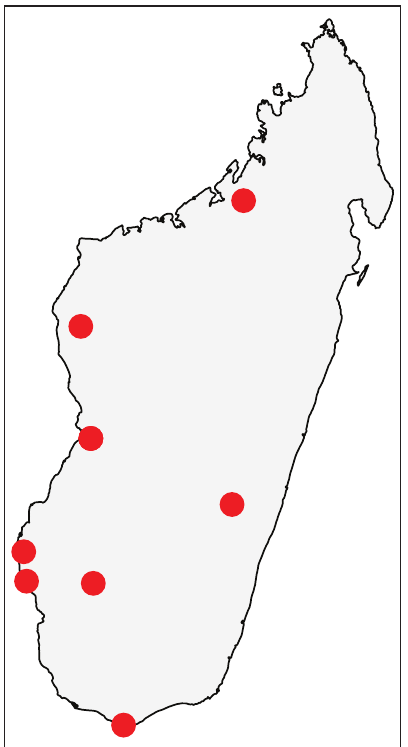
Figure 41. Geographic distribution of Nesomyrmex punctaticeps sp. n.. The known localities of N. punc- taticeps sp. n. in